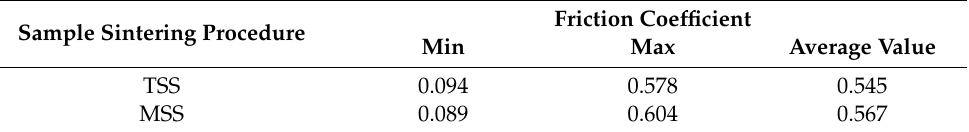
Table 3. The values of the friction coefficients for both cases (TSS and